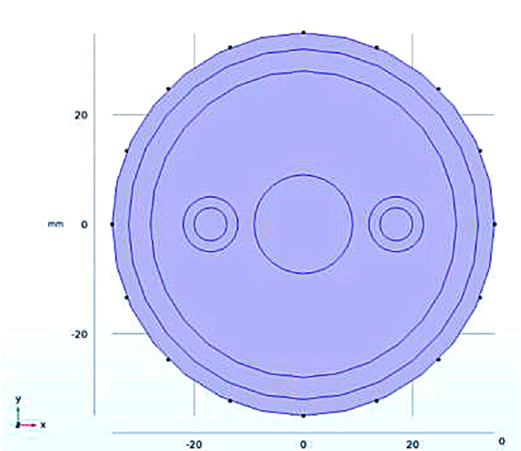
Figure 6. The position of the measured induced potential.